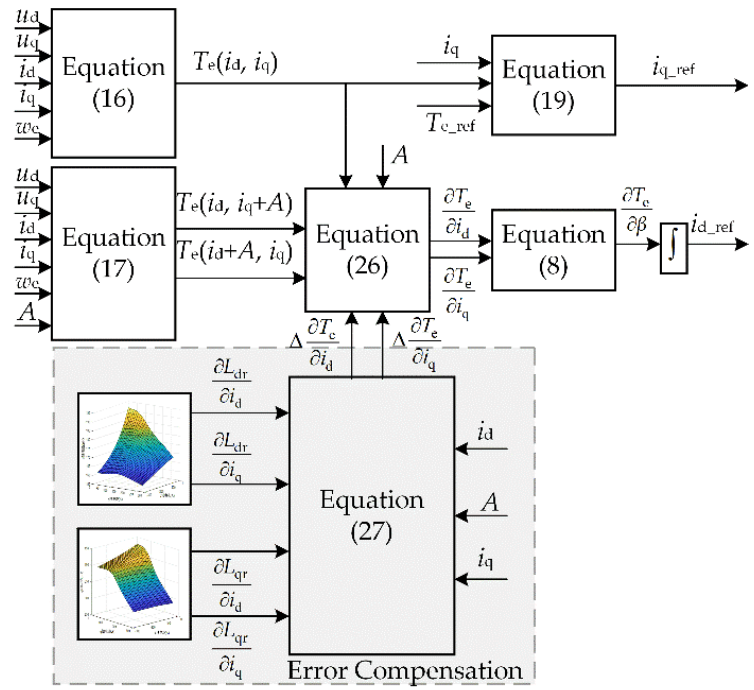
Figure 3. Block diagram of the proposed method.